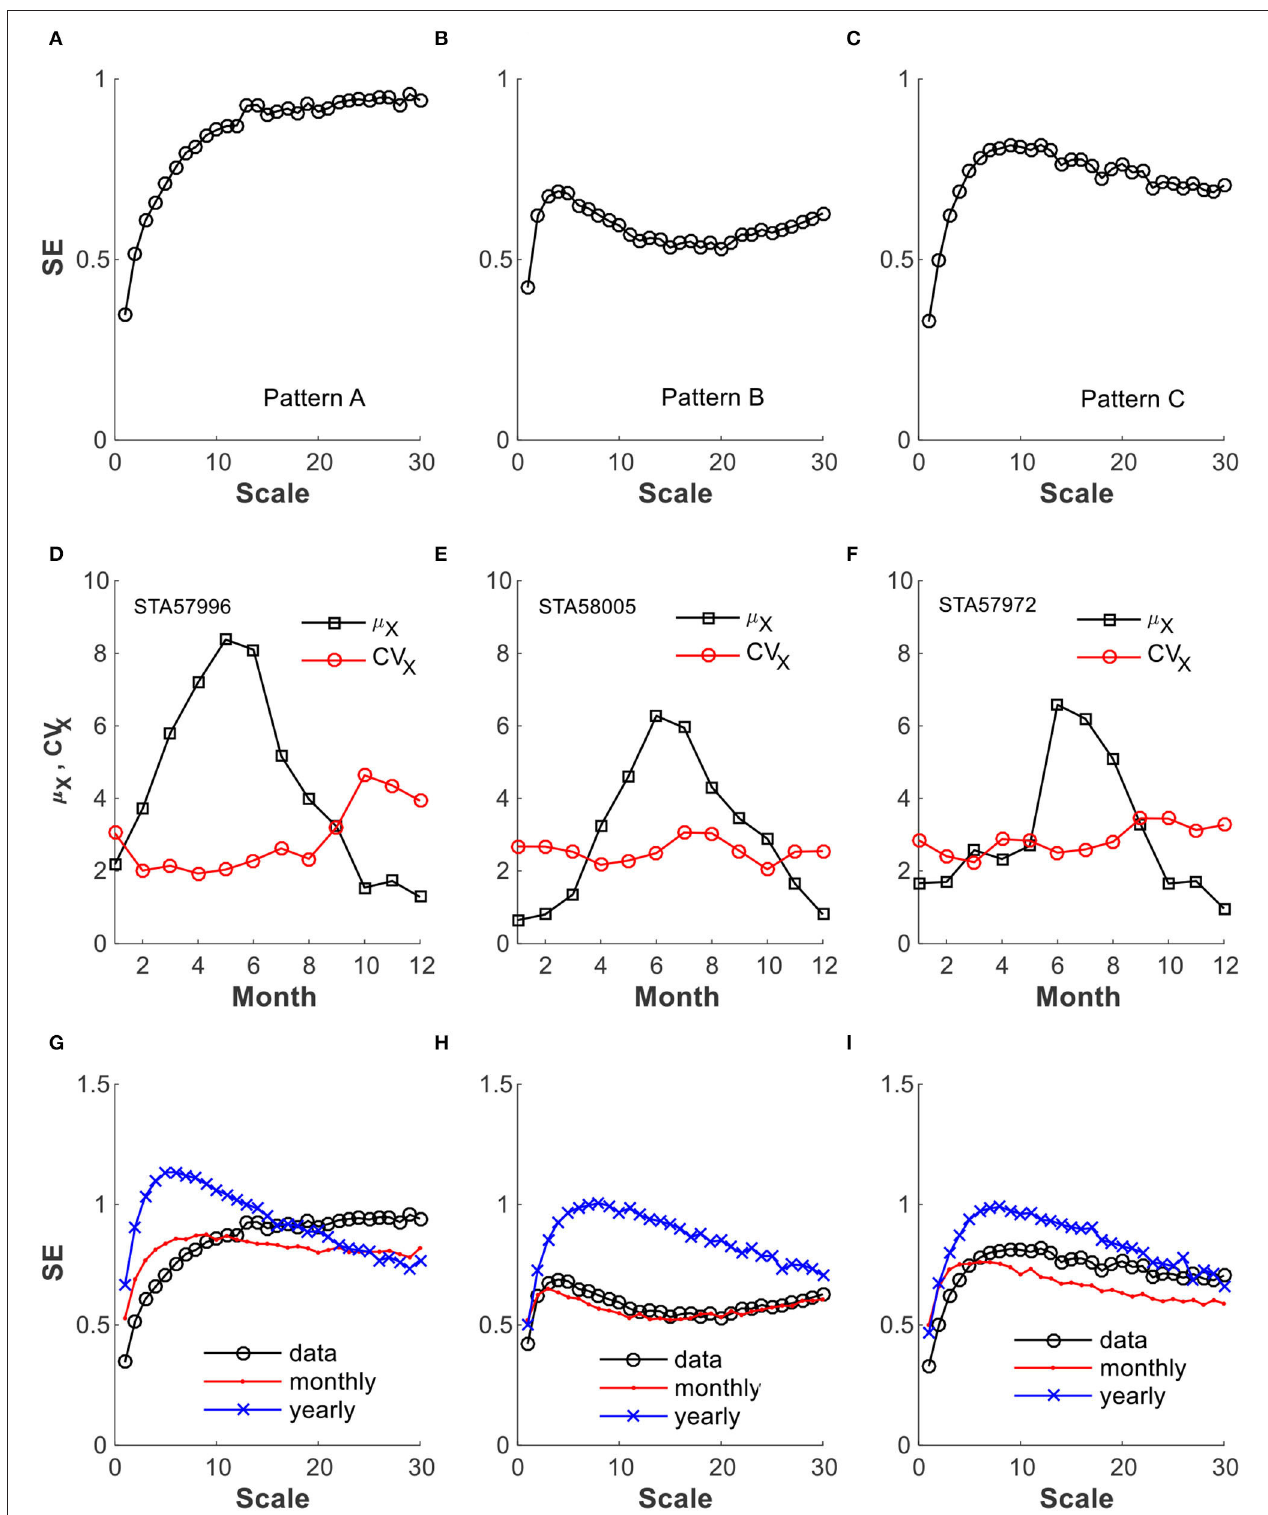
FIGURE 8 | Typical MSE patterns and a comparison with those from simulated precipitation: (A–C) represent MSE patterns A, B, and C; (D–F) are the monthly µ X and CV X of the time series where these patterns were obtained; and (G–I) include MSE from time series generated in two different ways.